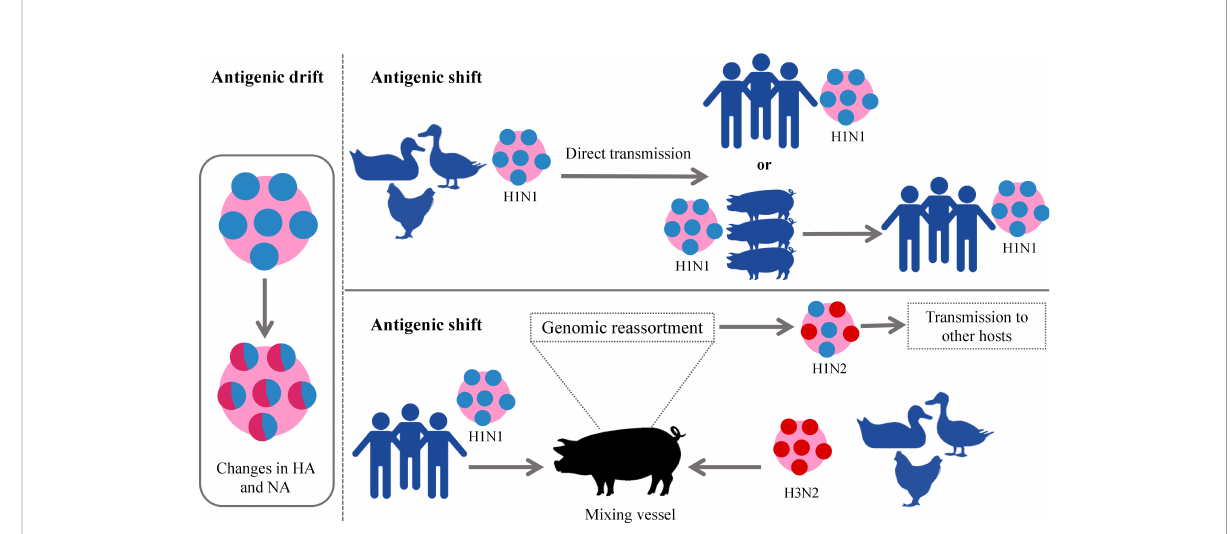
FIGURE 2 Schematic illustration of antigenic drift and shift in IAVs. In the left panel antigenic drift is demonstrated which results in small changes in viral glycoproteins. In the right panel, two forms of antigenic shift are exempli fi ed. Upper panel: direct jump of IAV strain from an animal to a human. Down panel: More complex form of antigenic shift – two different IAV strains infect the same animal (pig) which becomes a “ mixing vessel ” and genetic reassortment takes place. The “ mixing vessel ” then can transmit the new strain of IAV to another species, e.g., humans. IAVs, in fl uenza A viruses.